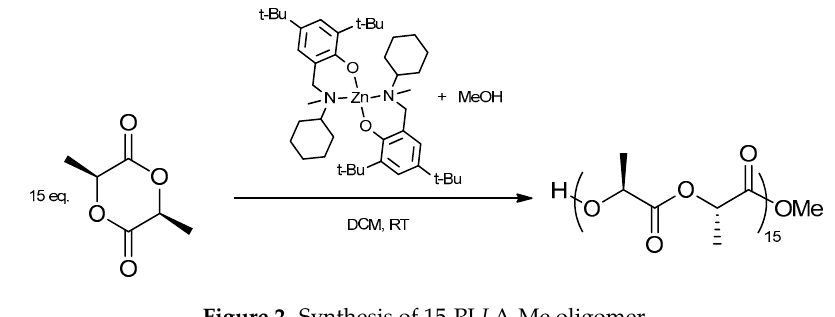
Figure 2. Synthesis of 15-PL L A-Me oligomer.